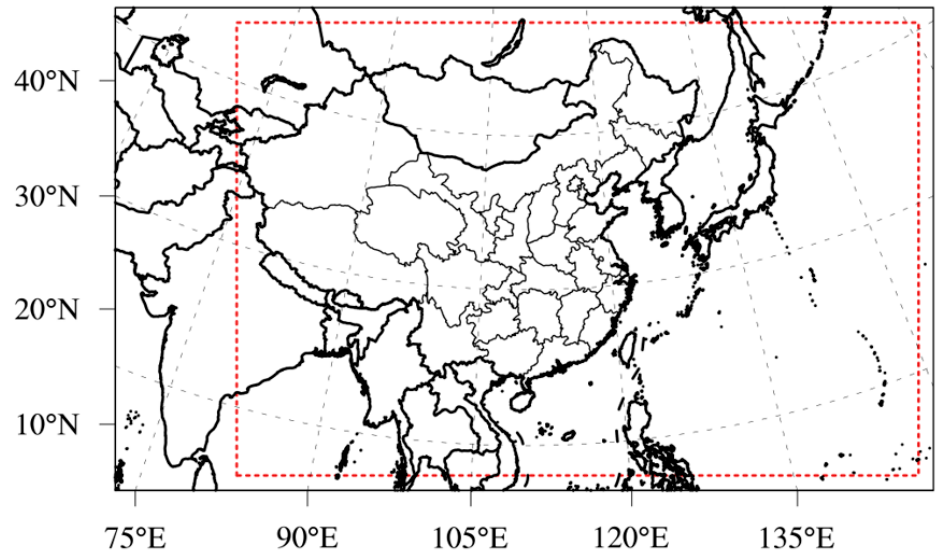
Figure 1. WRF-CMAQ domain. The black and red boxes represent the domains of WRF and CMAQ, respectively.